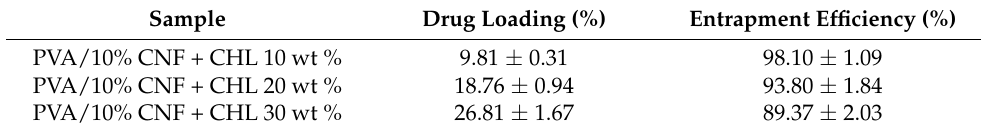
Table 2. Drug-loading and entrapment efficiency for the chloramphenicol loaded sponges.